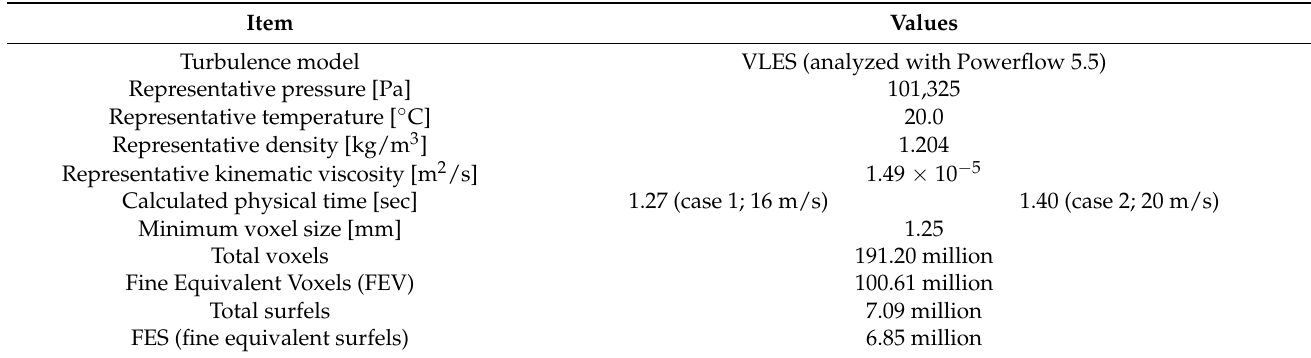
Table 1. Analysis